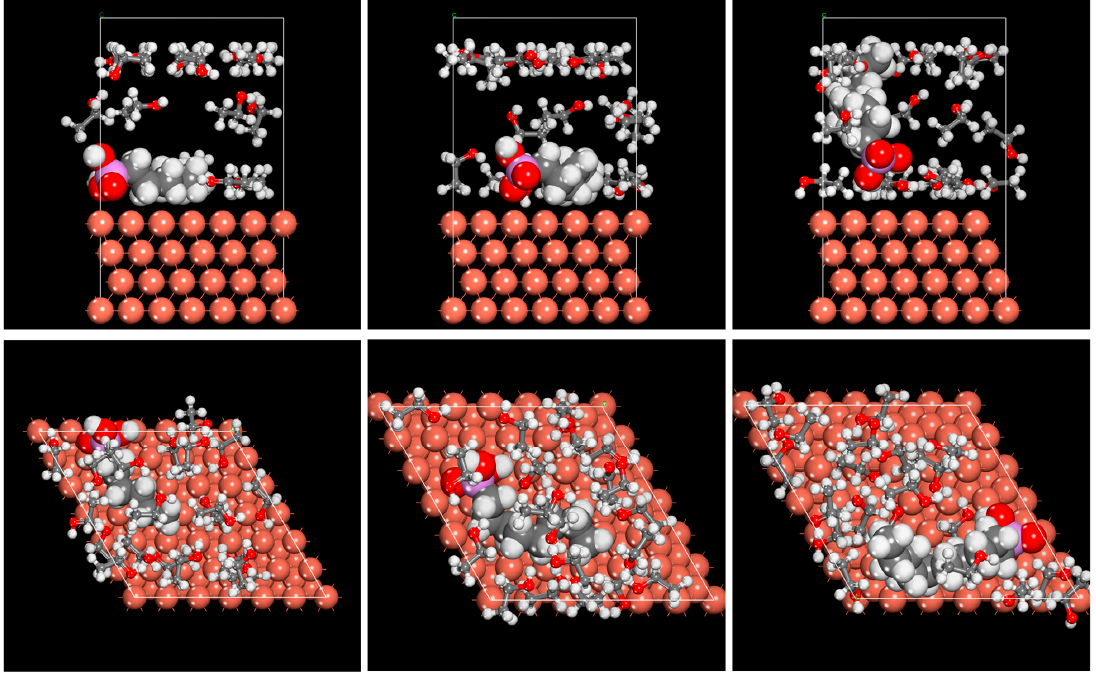
Figure 7. Top/side view of the equilibrium adsorption configuration of the alkyphosphonic acids’ adsorption onto Cu(111) surface computed in ethanol (1 alkylphosphonic acid molecule + 20 ethanol molecule) as obtained using the Monte Carlo simulation.